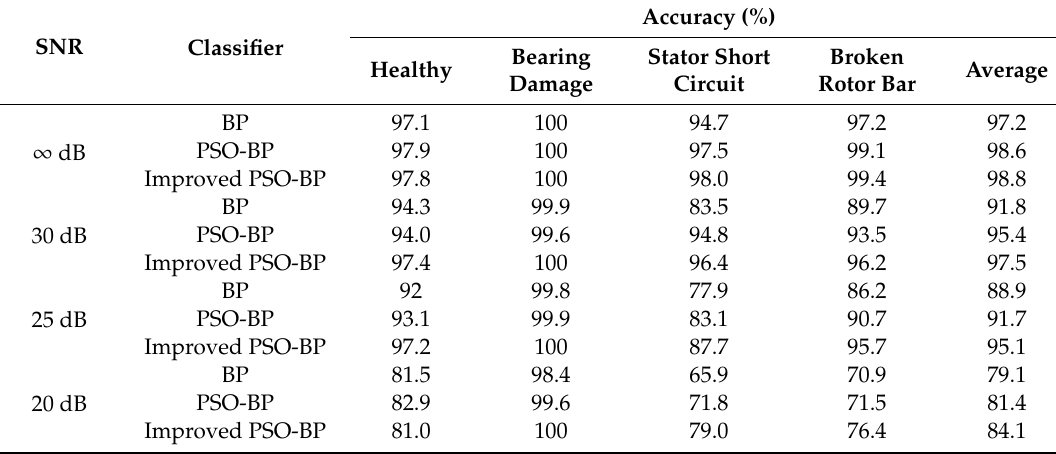
Table 2. Result of induction motor fault classification.